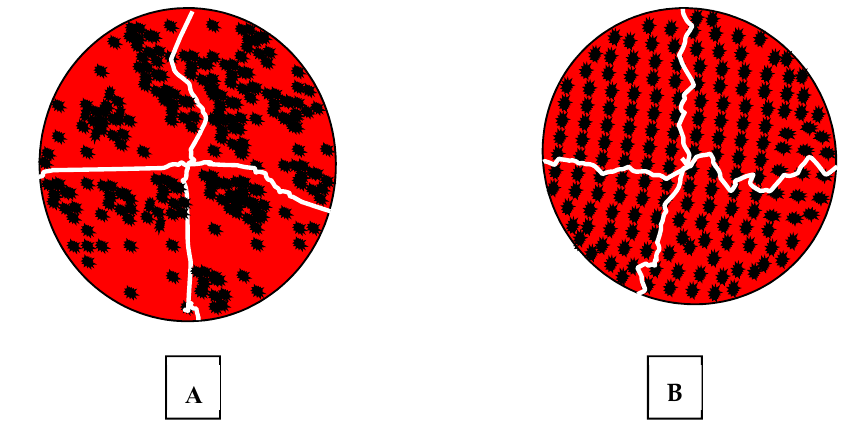
Figure 2. Schematic distribution of filler particles within the resin; ( A ) agglomerated, weekly bonded and randomly distributed particulates allow cracks to grow pass by them without obstruction. ( B ) uniformly dispersed particles, bonded to the resin matrix, divert cracks with increased fracture toughness of the material.